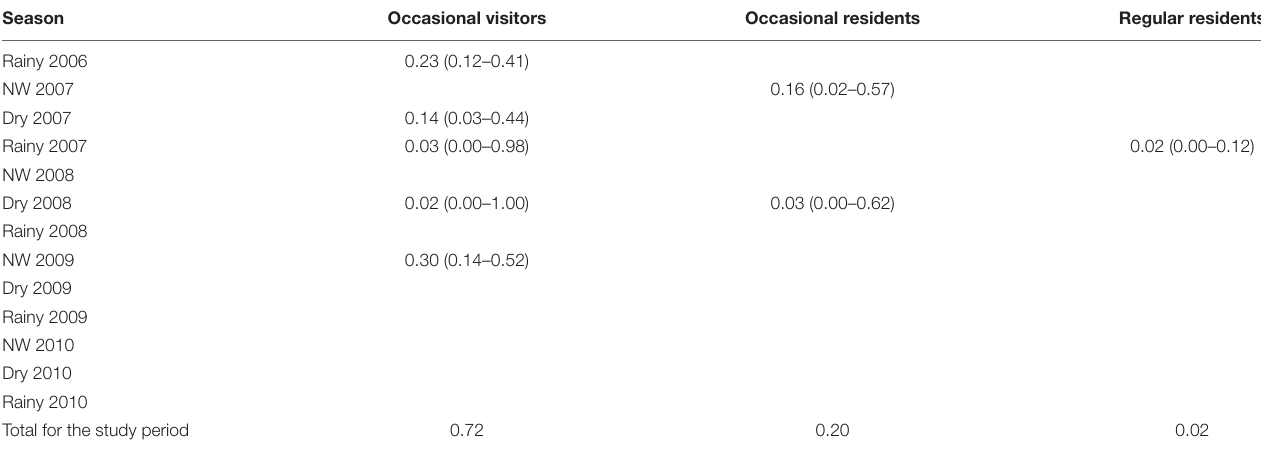
TABLE 3 | Recruitment from the superpopulation of the bottlenose dolphin off the Alvarado Lagoon System, southwestern Gulf of Mexico,